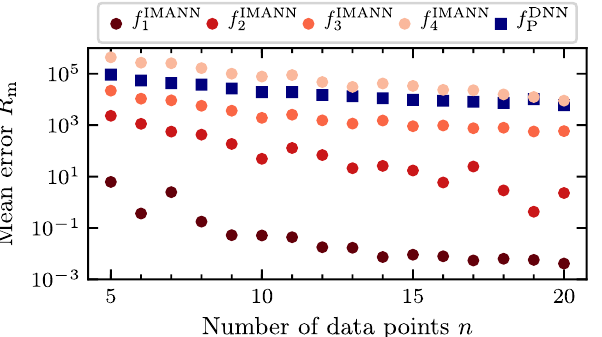
– f IMANN and f DNN change with 1 4 P